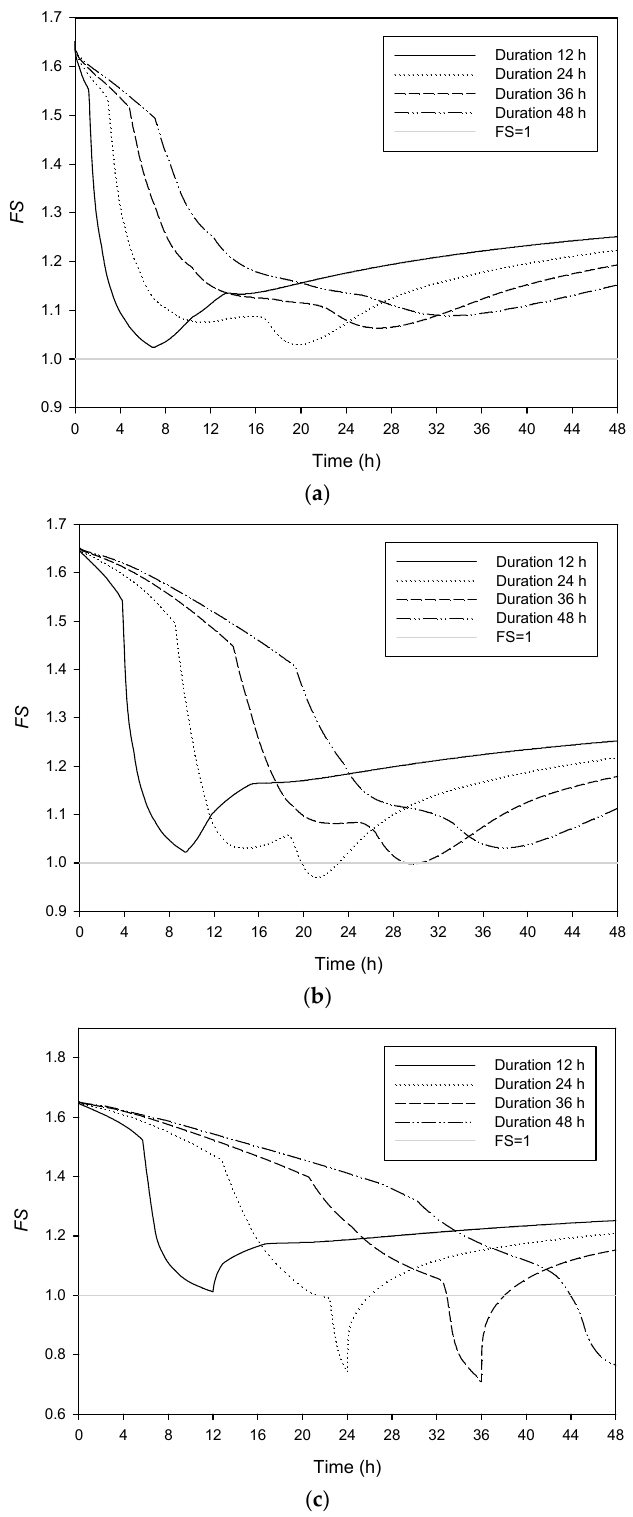
Figure 13. Factor of safety for various durations of 400 mm rainfall with rainfall patterns of: ( a ) advanced rainfall; ( b ) intermediate rainfall; and ( c ) delayed rainfall.